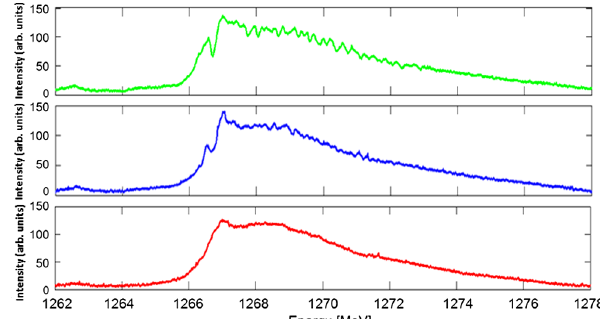
FIG. 7. Slice energy spread along the electron bunch. The green curve shows the energy spread measured with the LH off while the red curve shows the energy spread of the beam when heated at the maximum LH laser energy of 160 μ J. The magenta curve is obtained by subtracting in quadrature the LH-off from the LH-on curve. The blue curve shows the slice energy spread as predicted by the ELEGANT code.